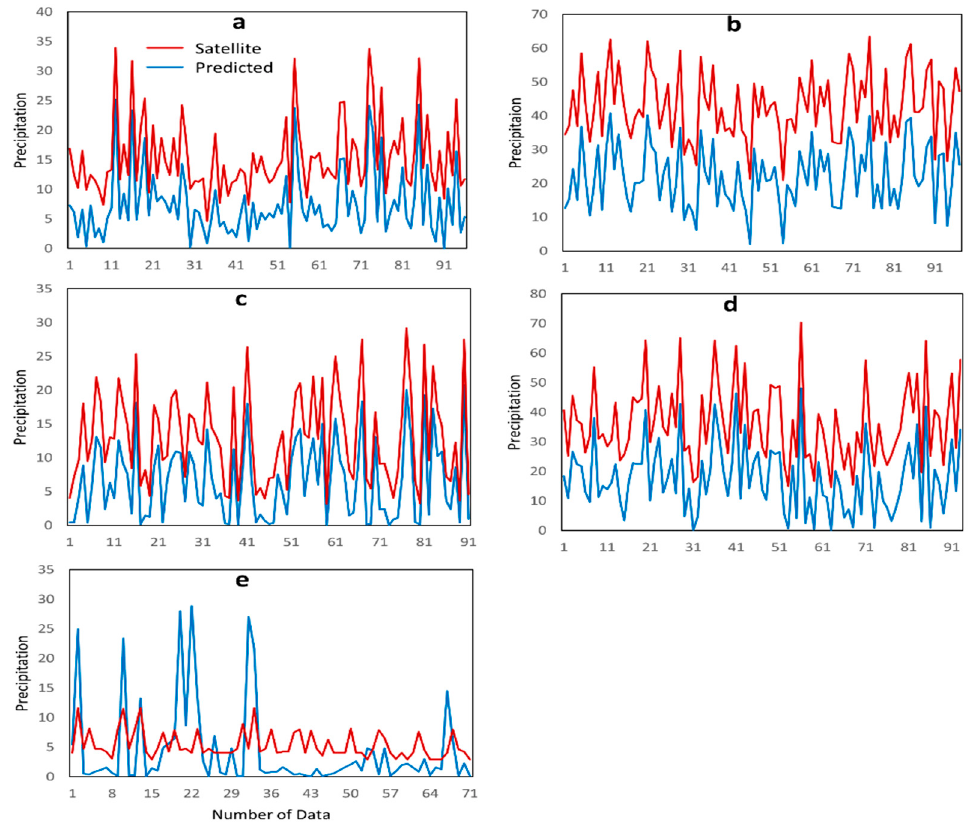
Figure 5. GA predicted precipitation of the five events over Northeast Austria for ( a ) 17 April 2015, ( b ) 23 May 2015, ( c ) 3 September 2015, ( d ) 25 September 2015, and ( e ) 7 October 2015.